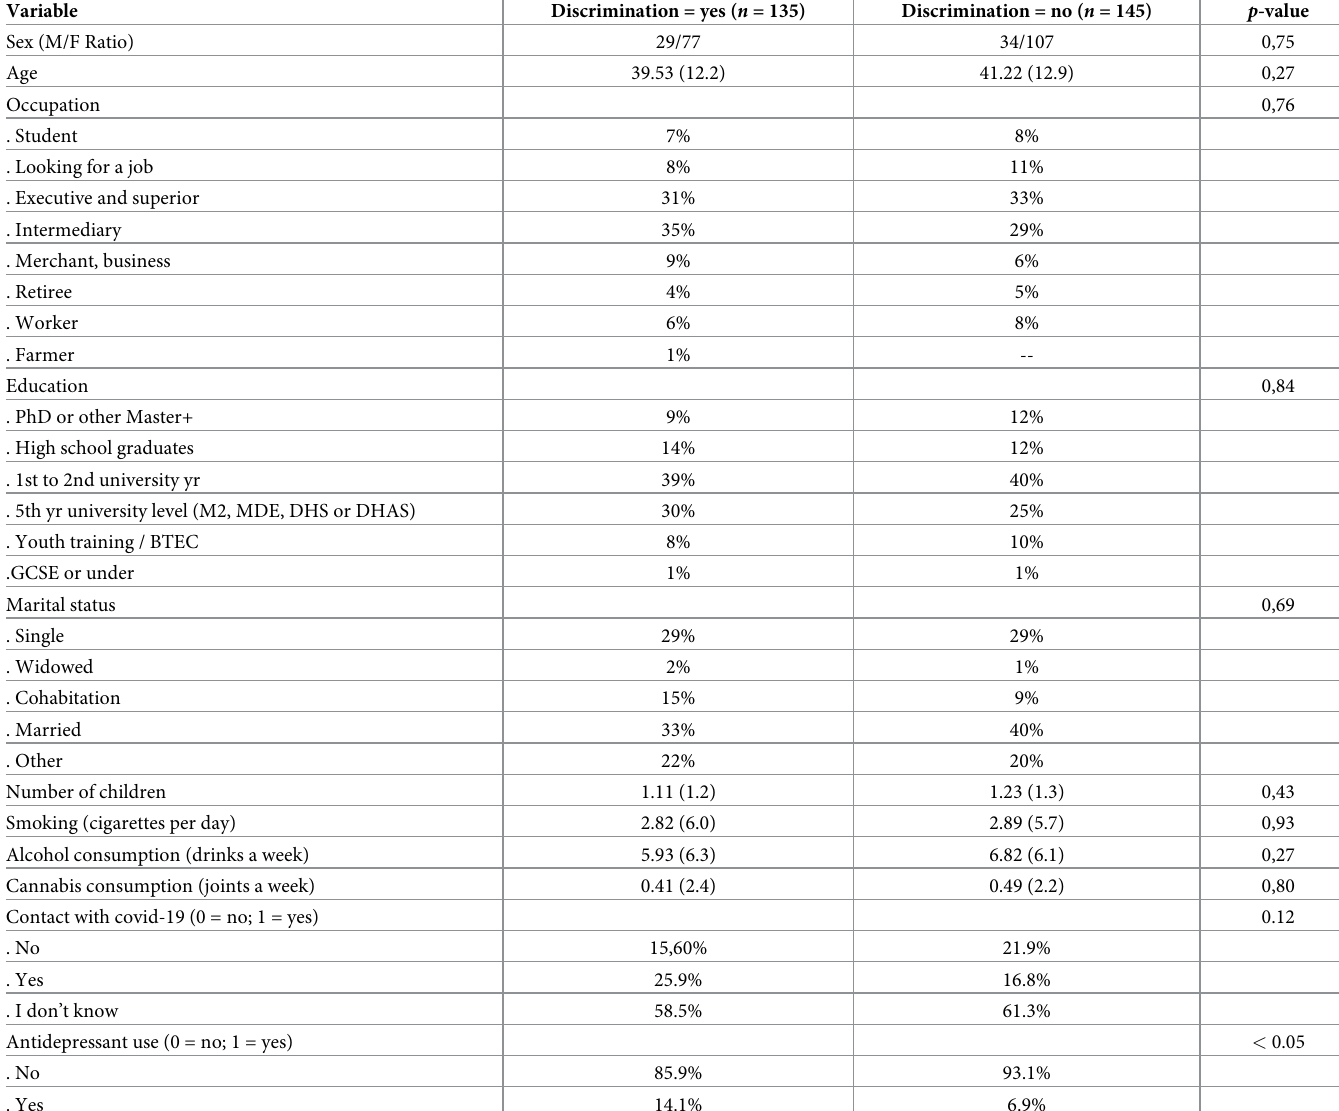
Table 1. Mean values (and standard deviations) for the main participants’ characteristics between the two groups (no- vs.